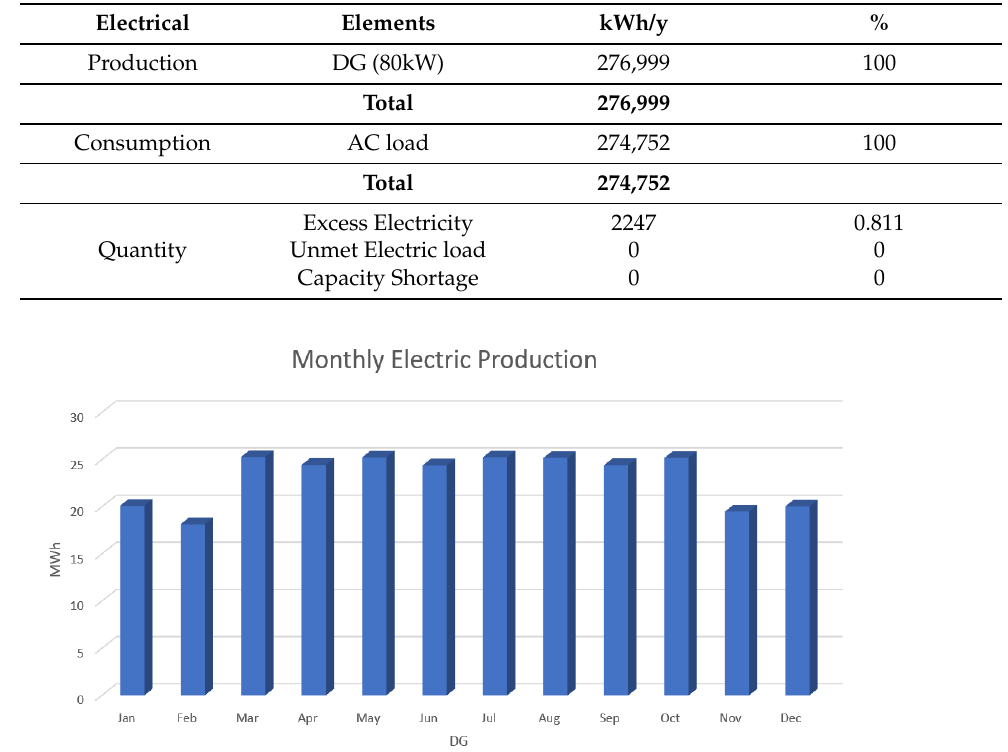
Figure 7. DG-based electricity production throughout the